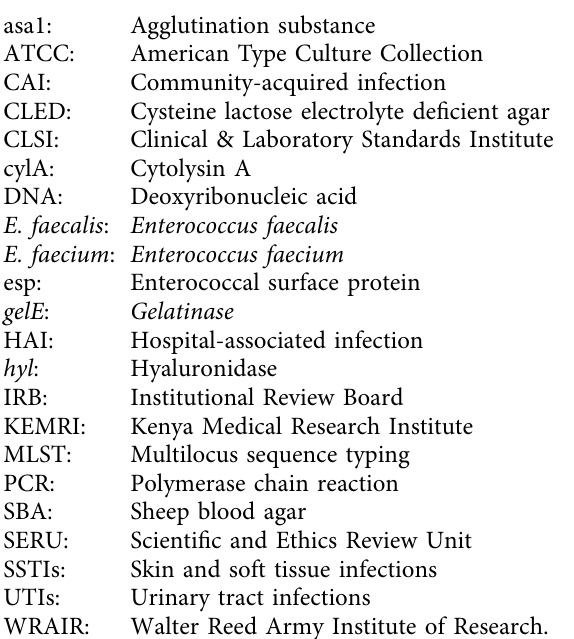
Supplementary Table 1: infection types, antibiotic resistance profles, and virulence genes for the Enterococcus spp.